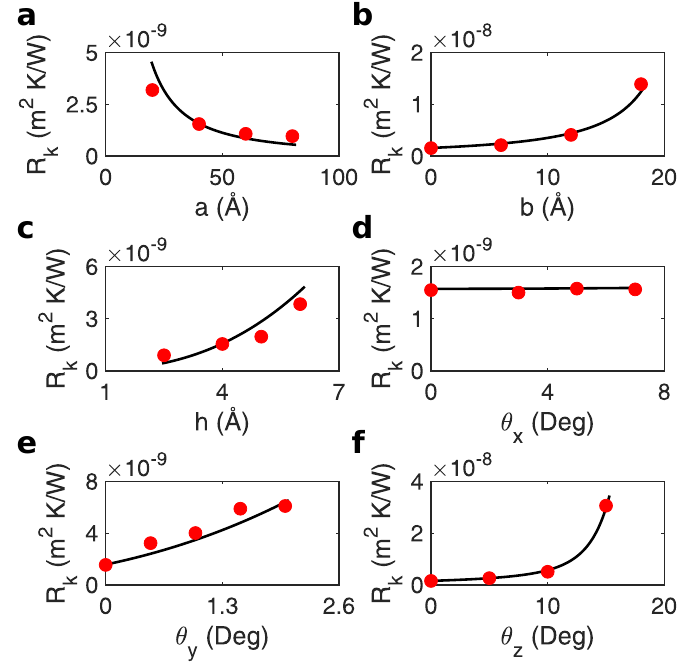
Figure 3. Interfacial thermal resistance ( R k ) at the GNR-GNR interface, as a function of ( a ) horizontal overlap a , ( b ) vertical overlap b , ( c ) interplanar spacing h , ( d ) angular displacement around x axis θ x , ( e ) y axis θ y , and ( f ) z axis θ z between adjacent GNRs. Molecular dynamics results (red dots) are fitted by the correlation reported in Equation (5) (black curves). Error bars are computed from time-block analysis of steady state trajectories and, when not visible, are smaller than symbol